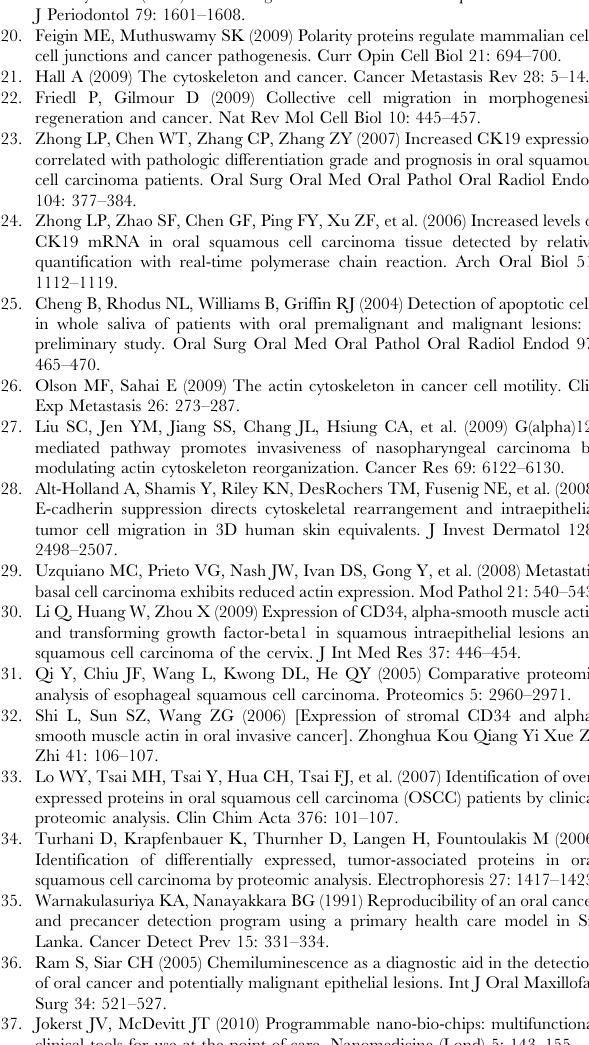
Table S2 Quantitative Proteomic Catalogue of Whole Saliva Soluble Fraction.